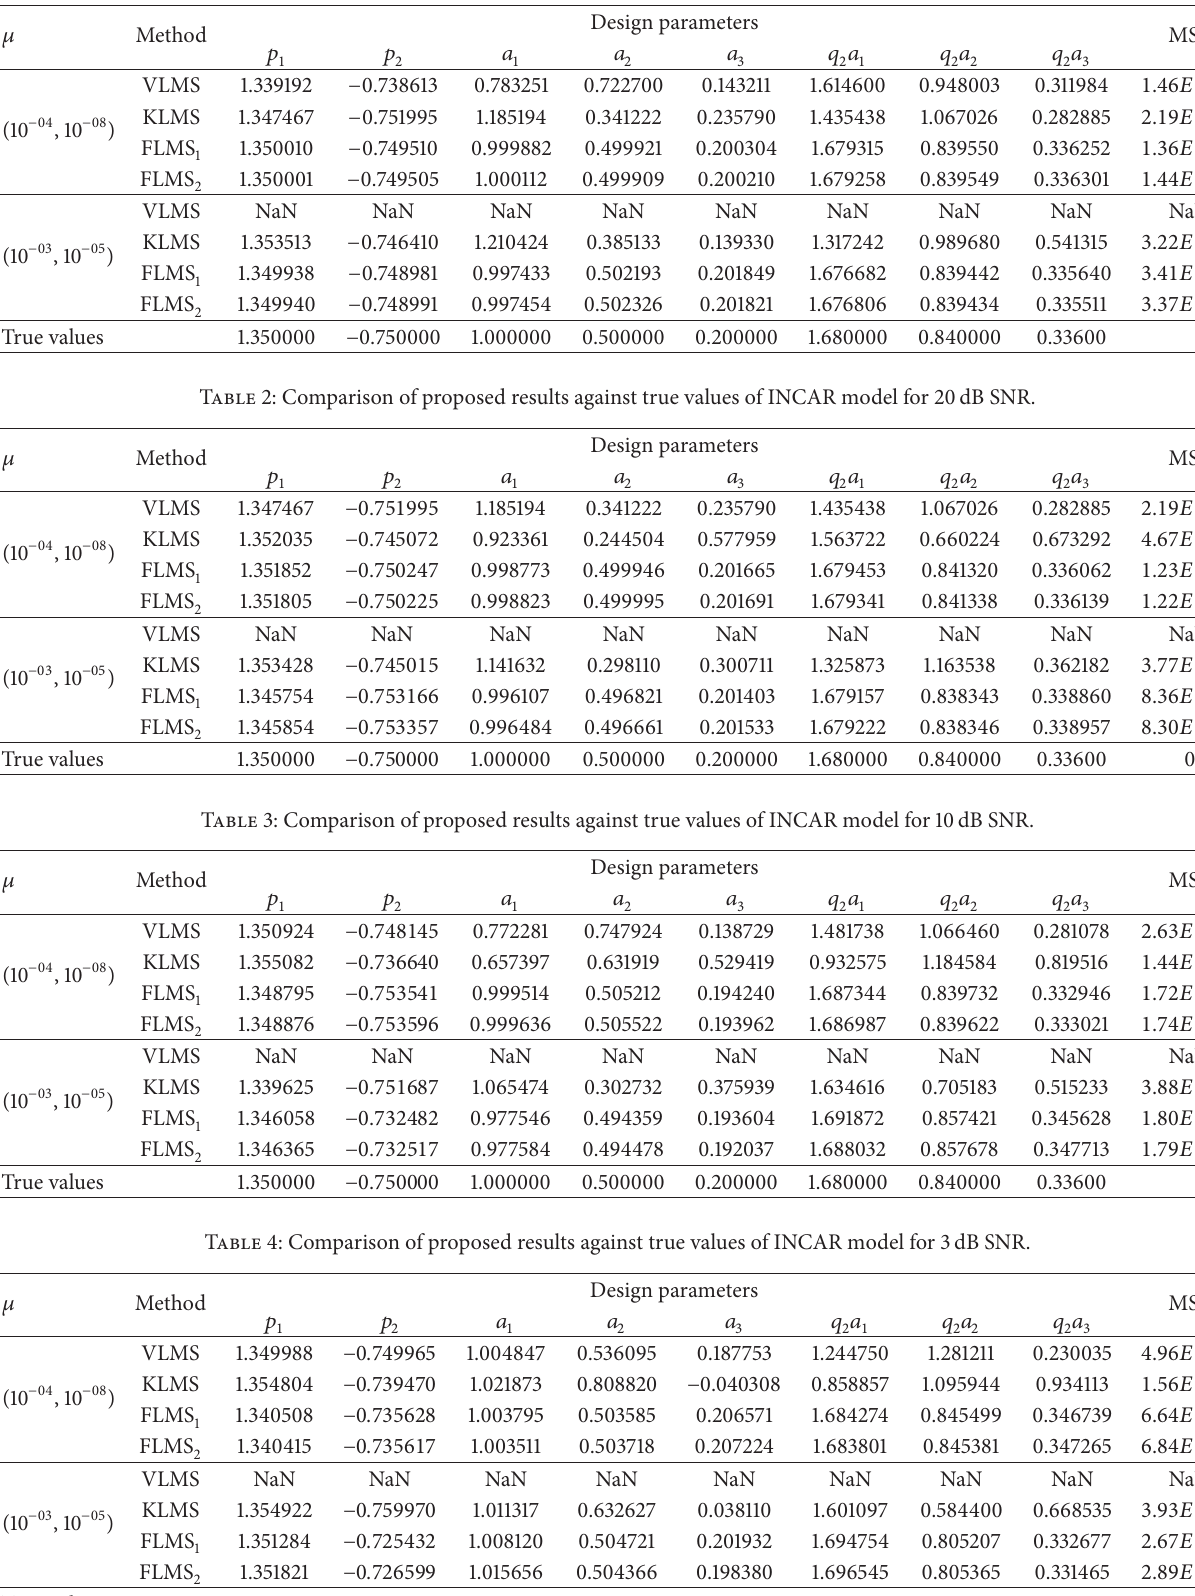
Table 1: Comparison of proposed results against true values of INCAR model for 30 dB SNR.